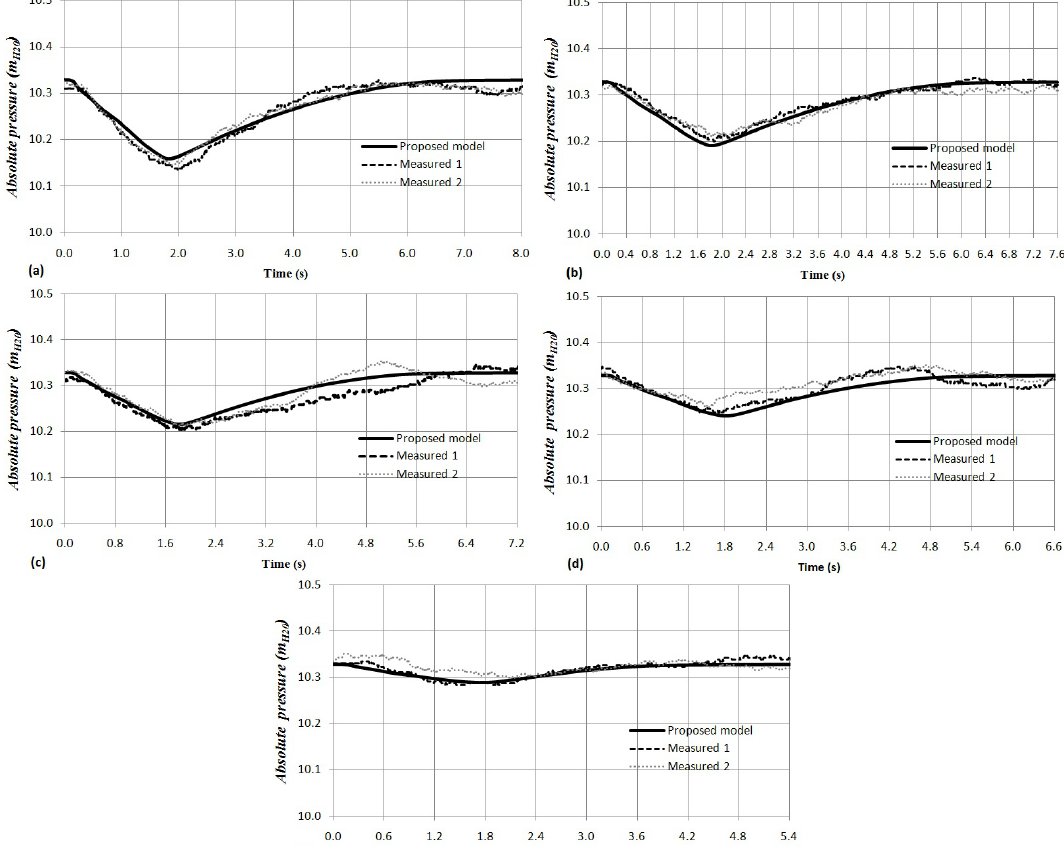
Figure 6. Comparison between computed and measured absolute pressure oscillation patterns (air valve D040): ( a ) Test No. 6; ( b ) Test No. 7; ( c ) Test No. 8; ( d ) Test No. 9; ( e ) Test No.